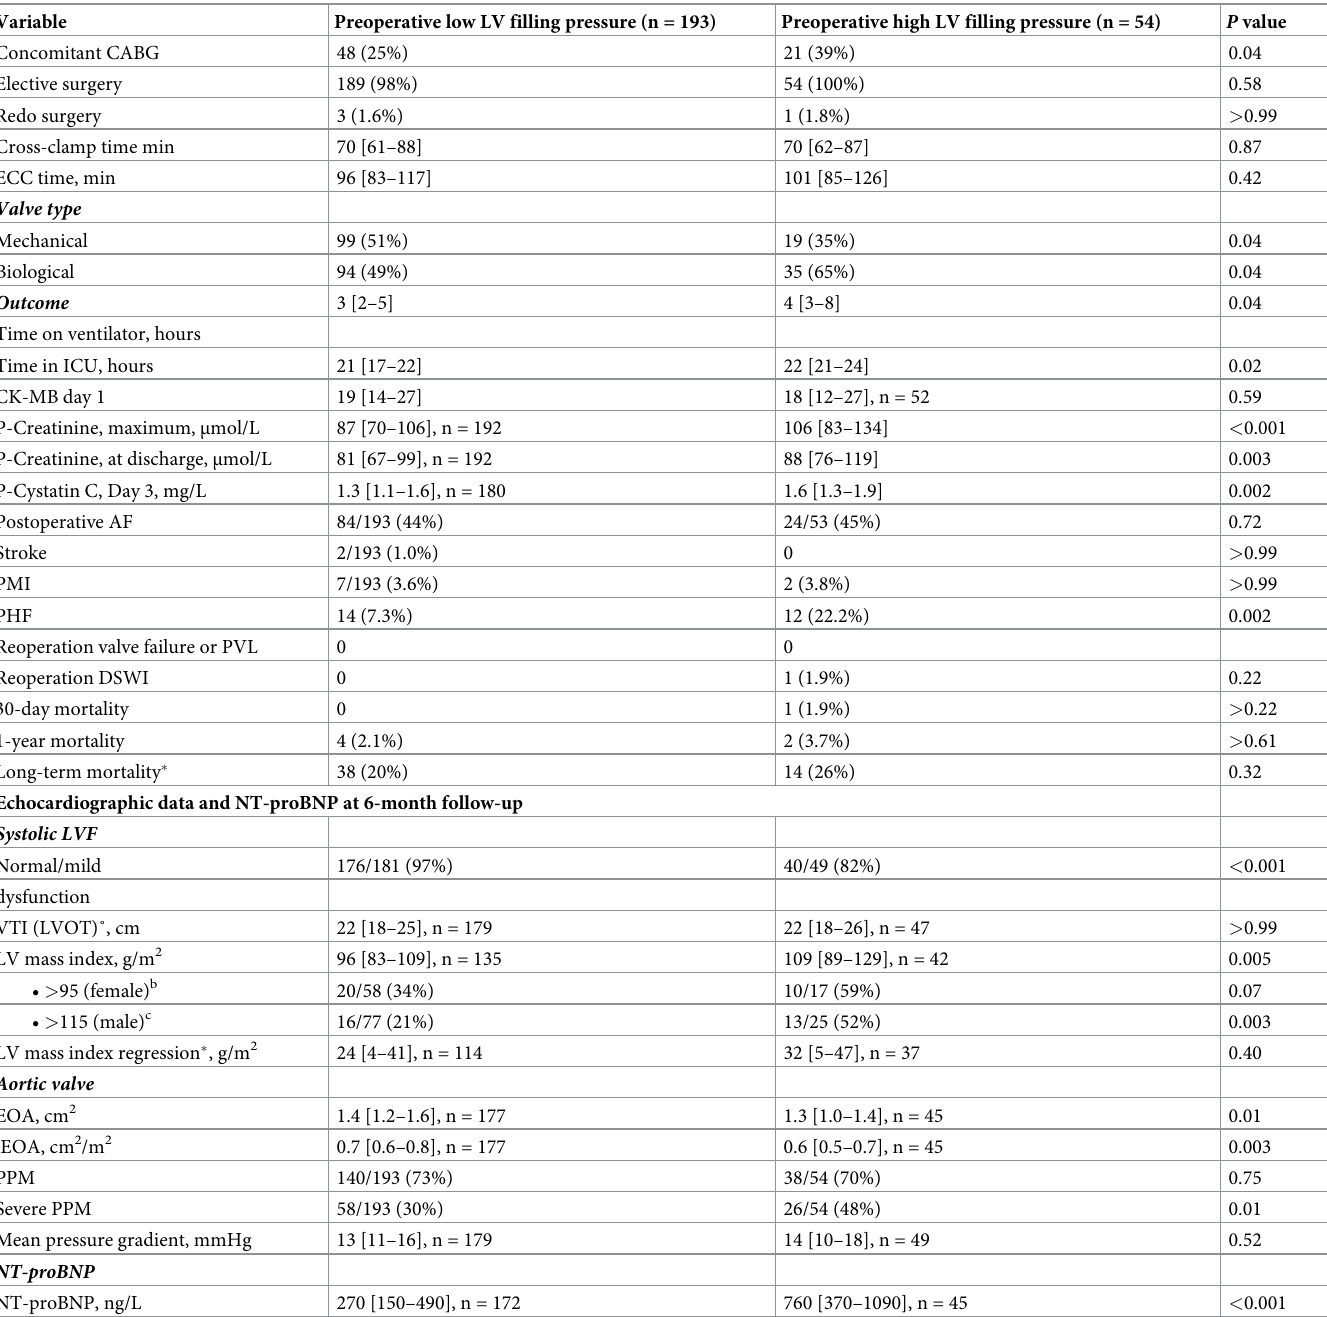
Table 2. Perioperative data and adverse